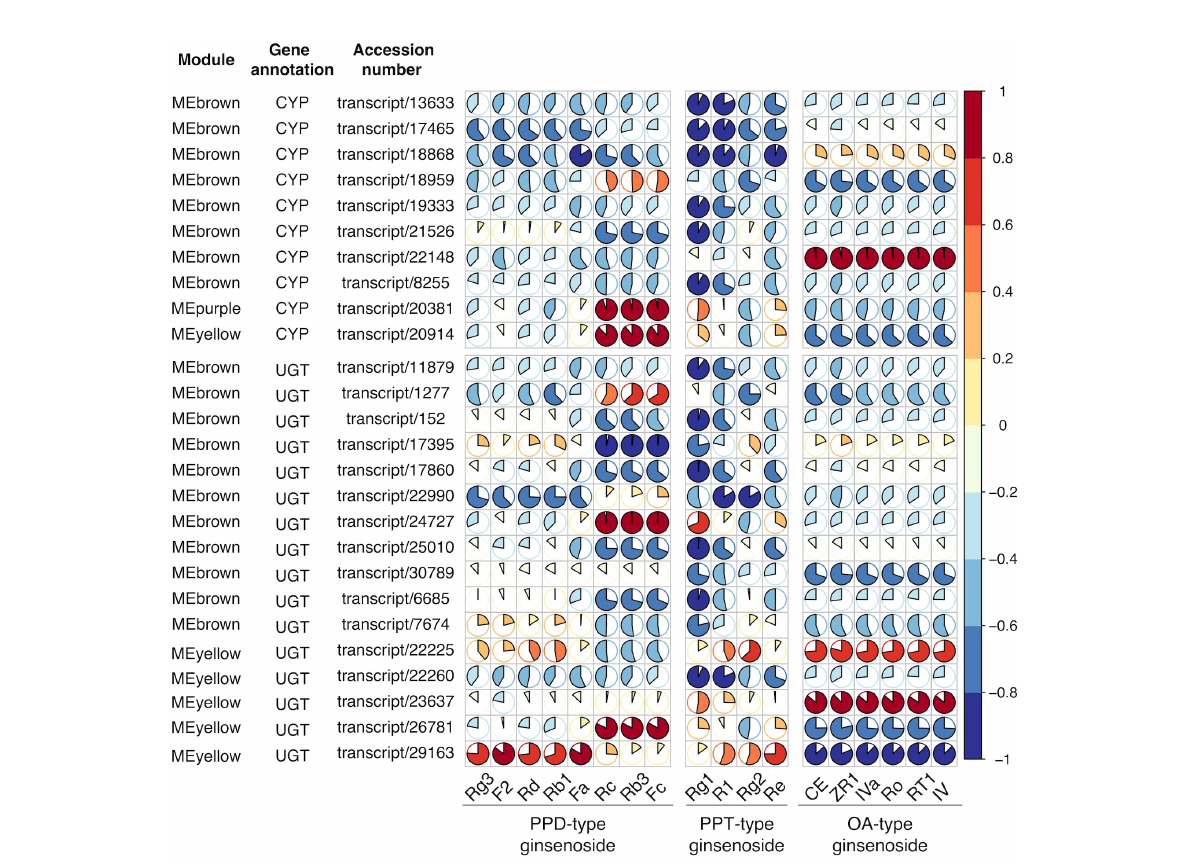
FIGURE 8 Pearson correlation analysis of target protein expression patterns and ginsenoside contents in different tissues. Based on integrated transcriptome and proteome analysis, 26 transcripts/proteins were identi fi ed. Pie plot to present the Pearson ’ s correlation of selected CYPs and UGTs annotated transcripts/proteome with investigated ginsenosides. The area of circles corresponds to correlation coef fi cient (R) values, and colors indicate whether a correlation is negative or